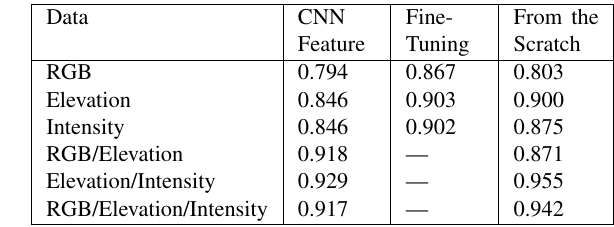
Figure 15. Classification samples of different sizes cars off the road. The left image shows cars parked closely together in a parking lot. The classifier is still able to classify them as single object. In the image on the right side, a classification example for two cars of completely different sizes is shown. Both, the small car and the caravan are classified as car.